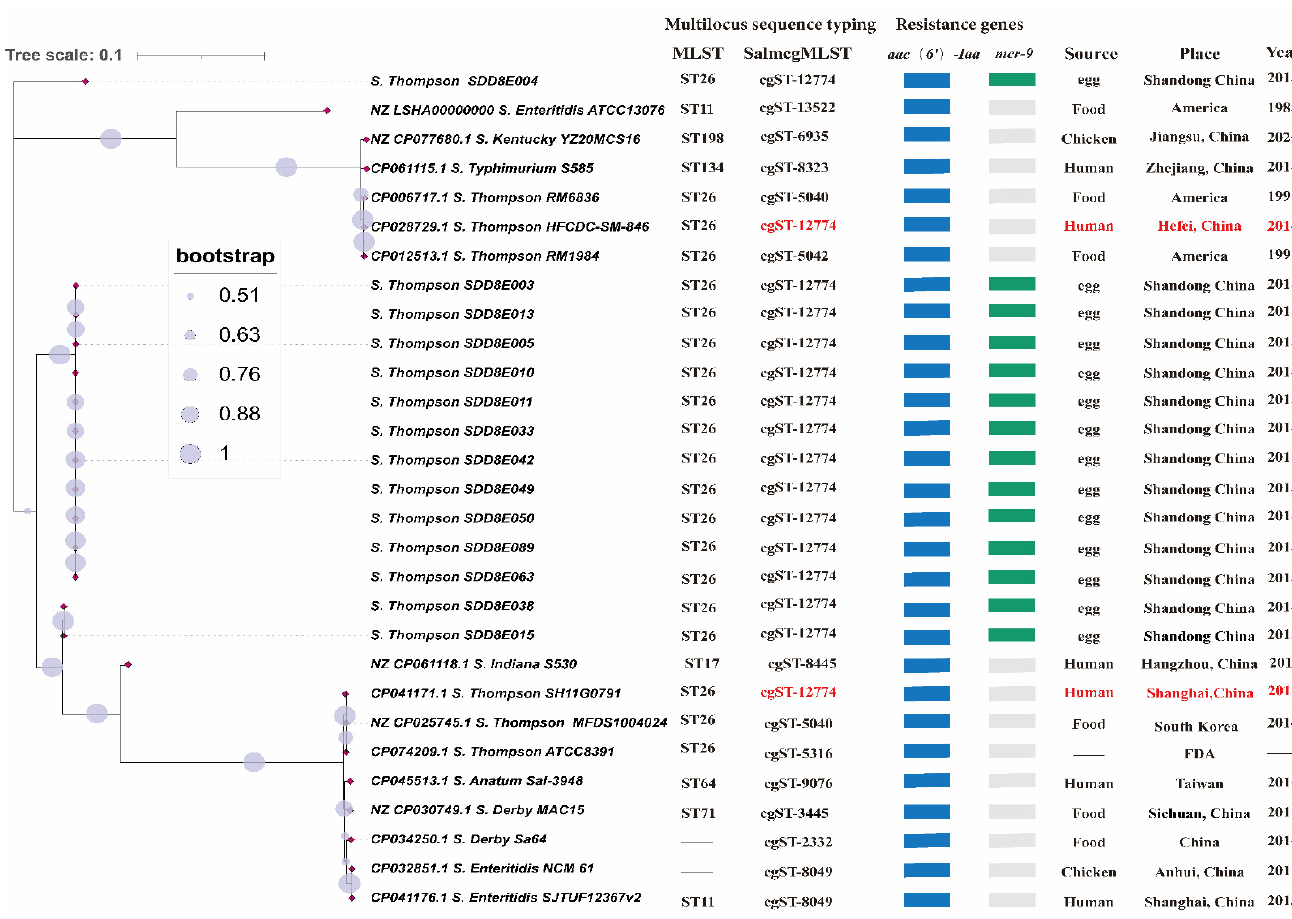
Figure 2. Phylogenetic tree of 14 S. Thompson isolates and 15 strains of different serovars from NCBI based on 16S rRNA and 7 house-keeping genes. MLST, cgMLST, and resistance genes (aac (6 ′ )-Iaa and mcr-9) of 29 Salmonella strains. The phylogenetic tree percentages were obtained using the bootstrap test using 500 replicates.